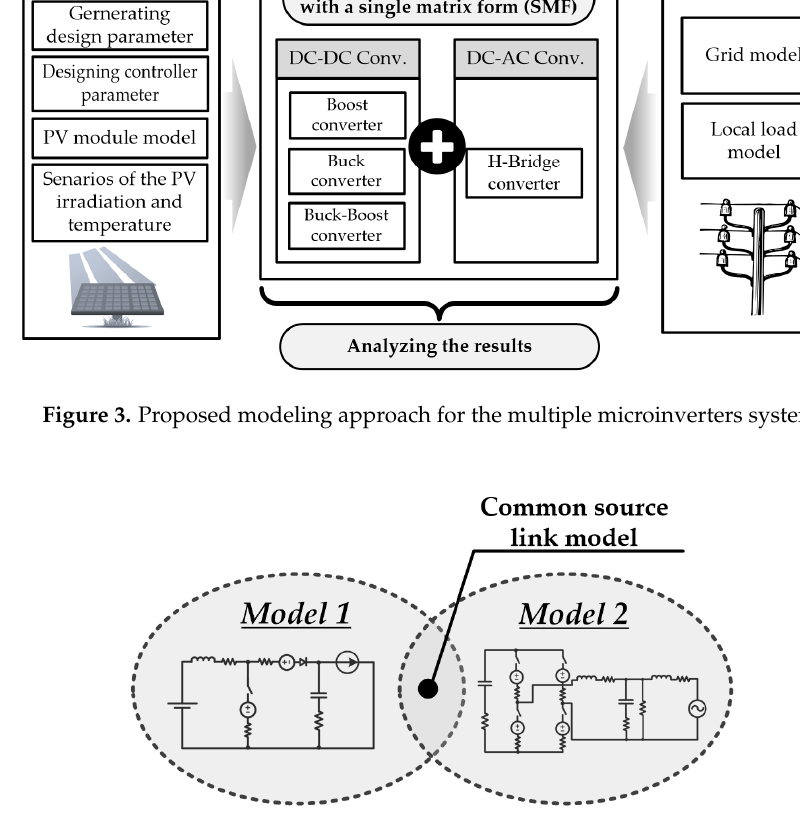
Figure 4. Multi-stage converter model with single matrix form.